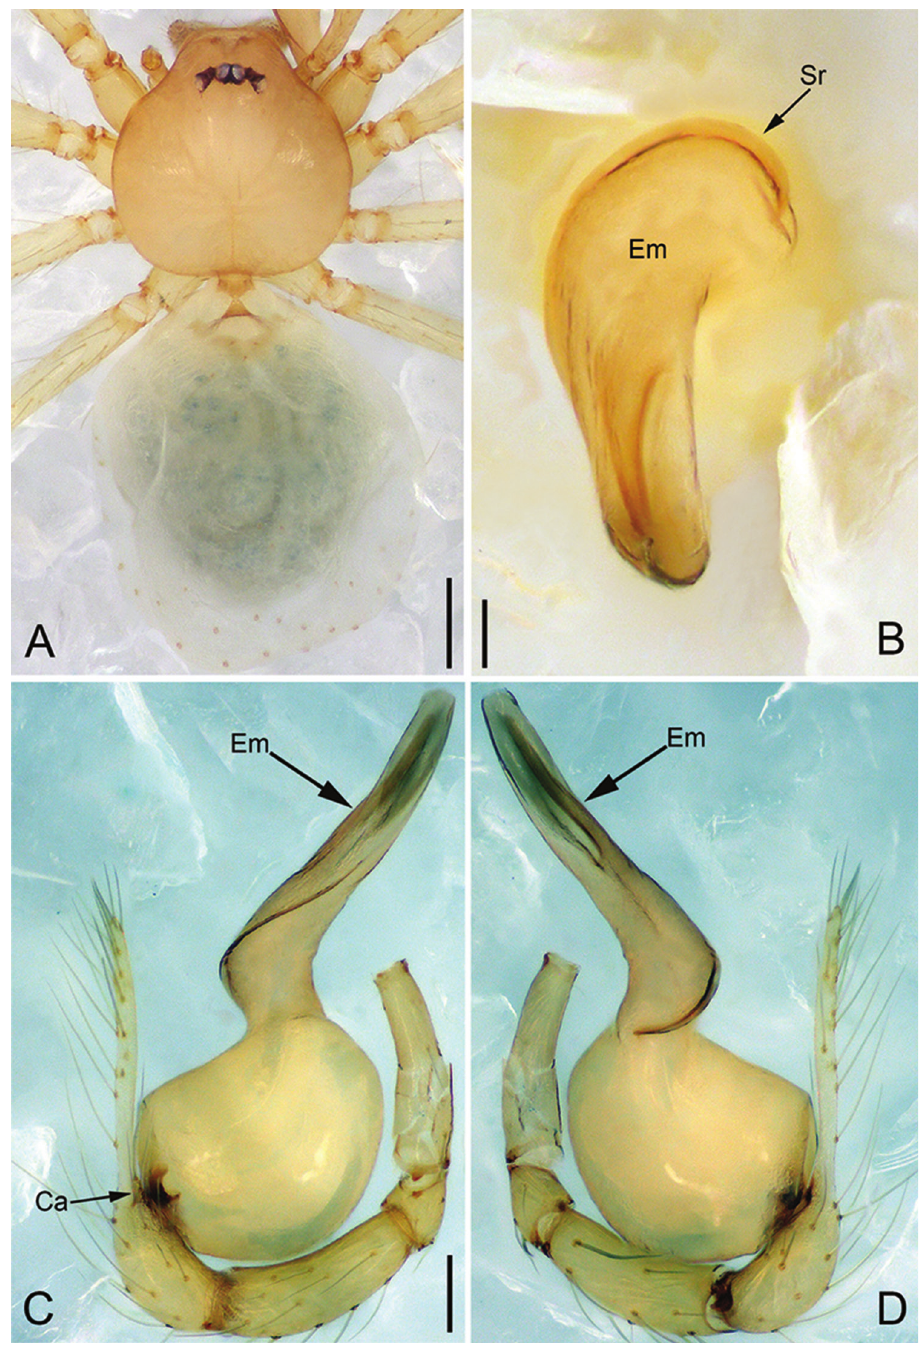
Figure 22. Pinelema wenyang Zhao & Li, sp. n., male holotype. A Habitus, dorsal view B Embolus, apical view C Palp, prolateral view D Palp, retrolateral view. Scale bars: 0.2 mm ( A ), 0.05 mm ( B ), 0.1 mm ( C–D